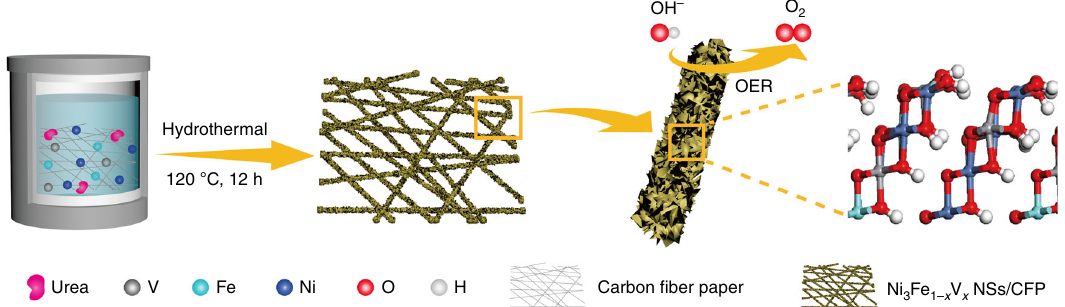
Fig. 1 Fabrication of Ni 3 Fe 1 ‒ x V x /CFP O 2 -evolving electrodes. Schematic illustration of the fabrication procedure by directly growing Ni 3 Fe 1 ‒ x V x NSs on a pretreated CFP substrate